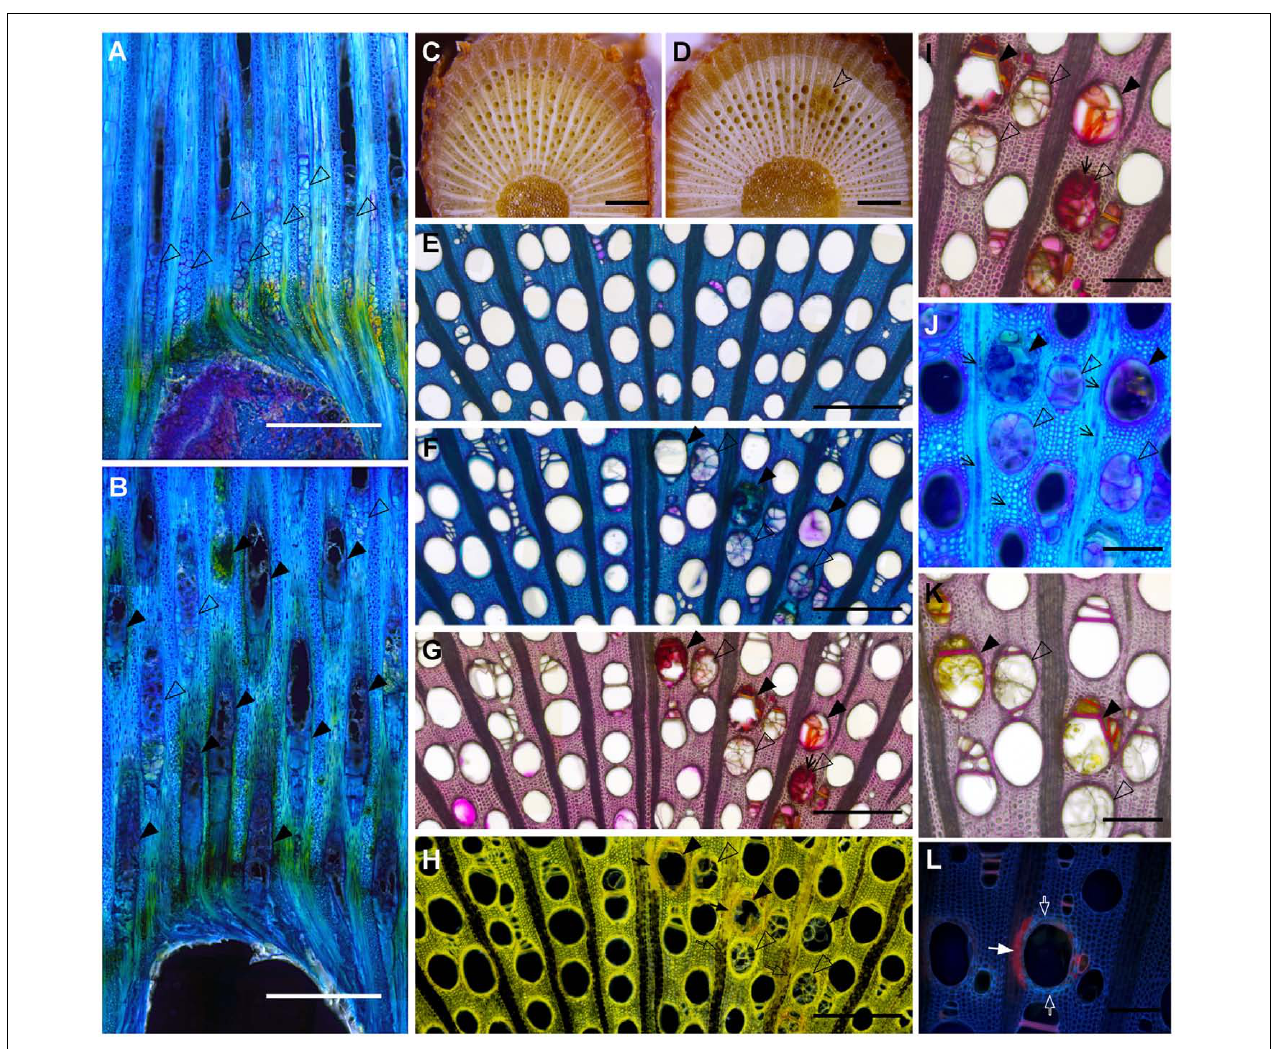
FIGURE 3 | Histological characterization of the compartmentalization process of P. chlamydospora in V. vinifera L. cv Cabernet Sauvignon stem. (A,B) Micrographs of tangential sections of Mock (A) and P. chlamydospora inoculated (B) plants showing the plant response right above the inoculation point (Toluidine O, dark field/phase contrast) 2 months post-inoculation. (A) Note the presence of vessel fully occluded by tyloses (hollow black arrowheads) about 1 mm above the wound in control plants and the presence of scar tissue at the inoculation point. (B) Note the presence of both fully occluded (hollow black arrowheads) and partially occluded vessels (solid black arrowhead) above the wound in P. chlamydospora inoculated plants and the absence of scar tissue at the inoculation point. (C,D) Pictures showing macroscopic phenotype 2 cm above the point of inoculation in Mock (C) and P. chlamydospora inoculated shoots (D) . Note the presence of typical wood necrotic lesion (hollow arrowhead) caused by P. chlamydospora (D) while no symptoms are observed in Mock inoculated plants (C) . (E) Micrograph of Mock inoculated stem in cross section 2 cm above the point of inoculation (bright field, toluidine O). (F–L) Micrograph of P. chlamydospora inoculated stem in cross section 2 cm above the point of inoculation (F , toluidine O, bright field; G and I , ruthenium red, bright field; H , iodine potassium iodide, dark field/phase contrast; J , toluidine O, dark field/phase contrast; K , phloroglucinol/HCl, bright field; L , sudan IV, epifluorescence UV). Note the presence of partially occluded vessels (solid black arrowheads) and fully occluded vessel (hollow black arrowheads) in the necrotic area of the xylem. (G,I) Large field (G) and close view (I) of section stained for the presence of pectin (ruthenium red). Note the presence of deep pink coloration that developed in partially occluded and some of the fully occluded vessels (black arrows) indicating the presence of gels rich in pectin. (H) Cross-section stain for the presence of starch (iodine potassium iodide). Note the complete depletion (black arrows) of starch (stained in black) in ray parenchyma cells next to partially occluded vessel (solid black arrowheads), while only partial depletion (hollow black arrows) occurs in ray parenchyma cells next to fully occluded vessels (hollow black arrowheads). (J) Micrographs showing the accumulation of putative non-structural phenolic compounds (staining in deep dark blue) in the lumen of ray parenchyma cells and some living fibers (black arrows) stained by the toluidine O. (K) Cross-section stained for the presence of lignin (phloroglucinol/HCl). Note the absence of change in purple color intensity in the wall of ray parenchyma cells and fiber surrounding partially and fully occluded vessel, indicating no substantial accumulation of structural lignin. (L) Cross-section stained for the presence of suberin (Sudan IV). The vessel presented in the center of the picture is partially occluded. Note the presence of enhance autofluorescence in the cell wall of paratracheal parenchyma cells and fibers surrounding the vessel (hollow white arrow), that could be attributed to the infusion of non-structural phenolics. Also note the presence of red fluorescence indicating a deposition of suberin in the wall of ray parenchyma cells next to the vessel (solid white arrow). (A–D) scale bar = 1000 µ m. (E–H) scale bar = 500 µ m. (I–L) scale bar = 200 µ m.